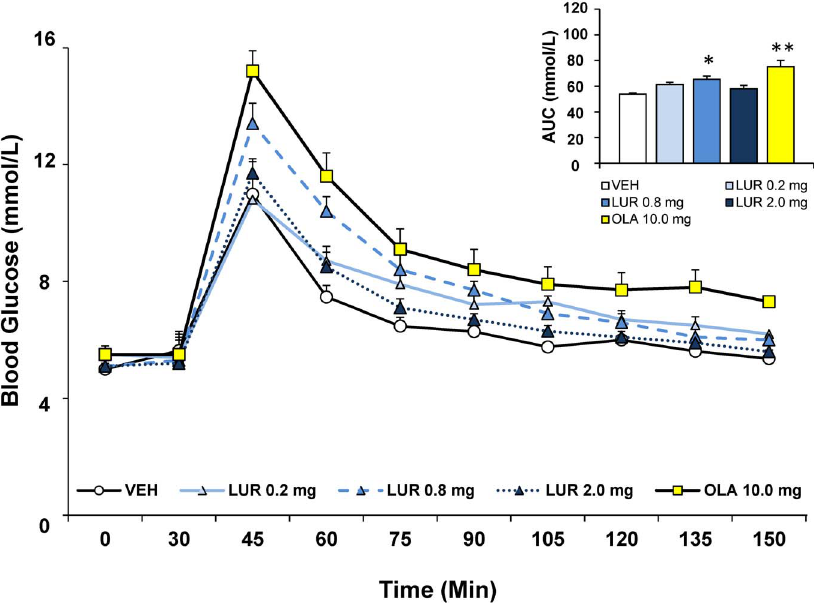
Figure 2. Acute effects of the SGA drugs lurasidone and olanzapine on glucose levels in adult female rats in the glucose tolerance test. Animals (n=8 per group) received a single injection of vehicle, lurasidone (0.2, 0.8 or 2.0 mg/kg, s.c) or olanzapine (10 mg/kg, s.c.) in a volume 1 ml/kg. Glucose levels were recorded prior to drug treatment in overnight-fasted rats at Time 0, and then 30 minutes following drug administration ( x-axis ). Immediately following this glucose measurement, all rats were subjected to a glucose tolerance test by receiving an intraperitoneal challenge injection of 1 g/ml/kg of glucose, and blood glucose levels were measured every 15 minutes for the next two hours. Total cumulative glucose levels for each treatment group are summed as the ‘‘area under the curve’’ during the glucose tolerance test by graph inset ( top right ). Values represent group means 6 SEM; *indicates different from vehicle-treated animals, p , 0.01; **indicates different from vehicle-treated animals, p , 0.001. doi:10.1371/journal.pone.0107116.g002 glucose tolerance and insulin resistance. The GTT measures the ability of a fasted subject to return glucose levels to normal represent the most reliable and accurate methods of determining following a glucose challenge, and the procedure is commonly